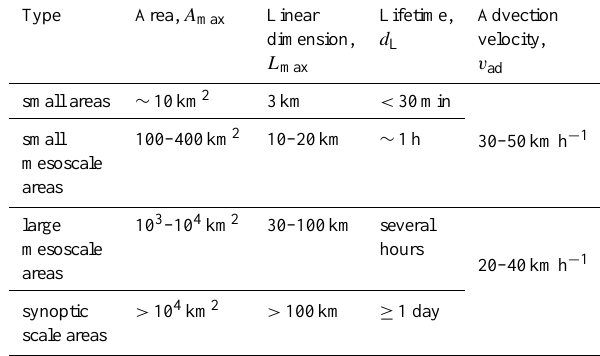
Table 8. Categories of precipitation areas and their characteristics; adapted from Langousis